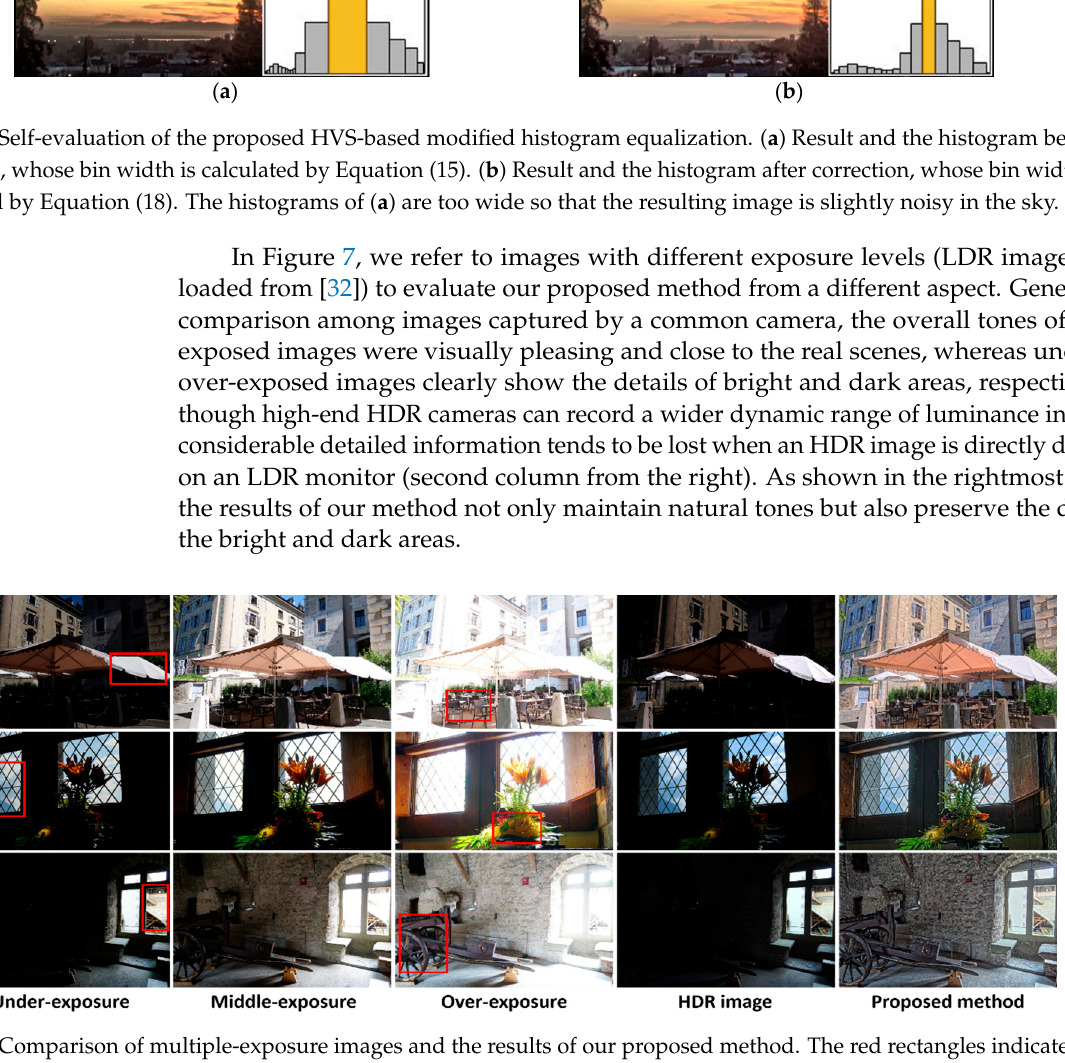
Figure 7. Comparison of multiple-exposure images and the results of our proposed method. The red rectangles indicate the areas which should be closely examined by the reader.